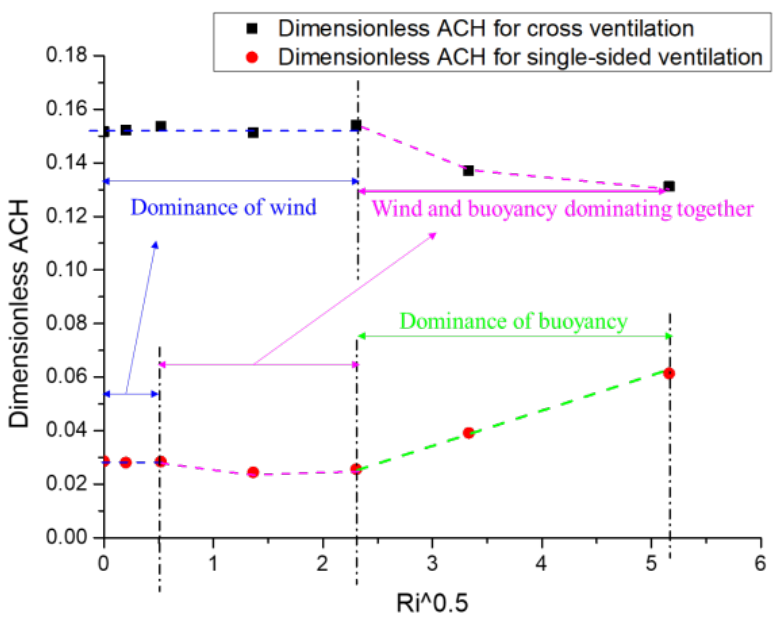
Figure 10. Dimensionless ACH against the square Ri numbers for cross- and single-sided ventilation (dotted lines in different color represent the Ri ranges of dominance of wind or buoyancy).